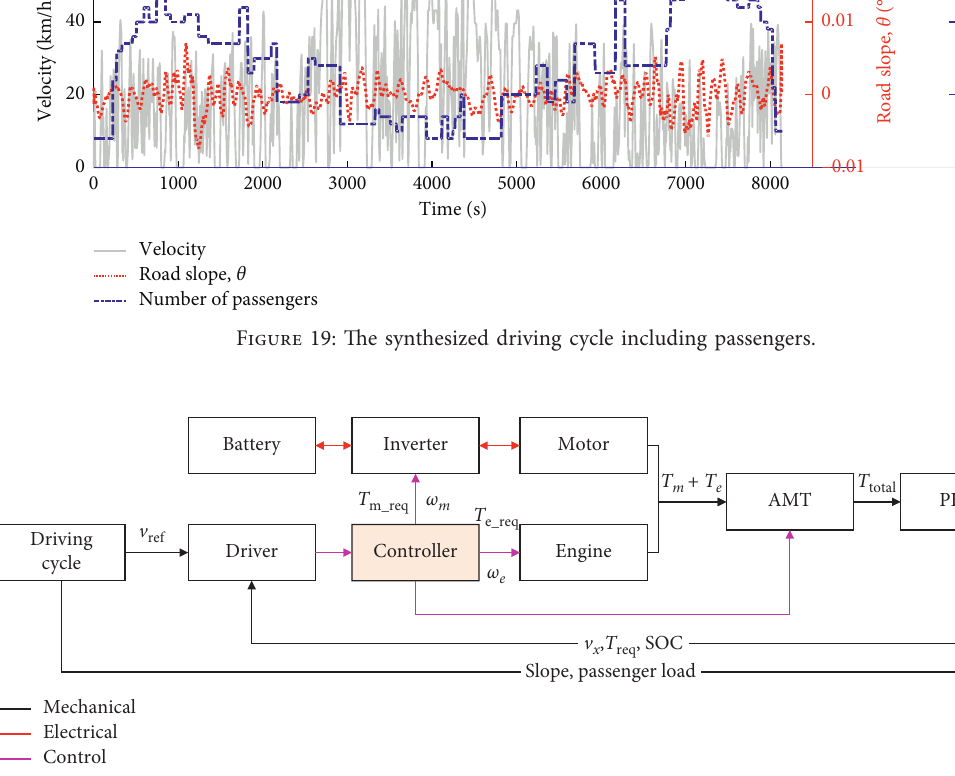
Figure 20: The flow diagram of the simulation model. Table 3: Main parameters of the simulation